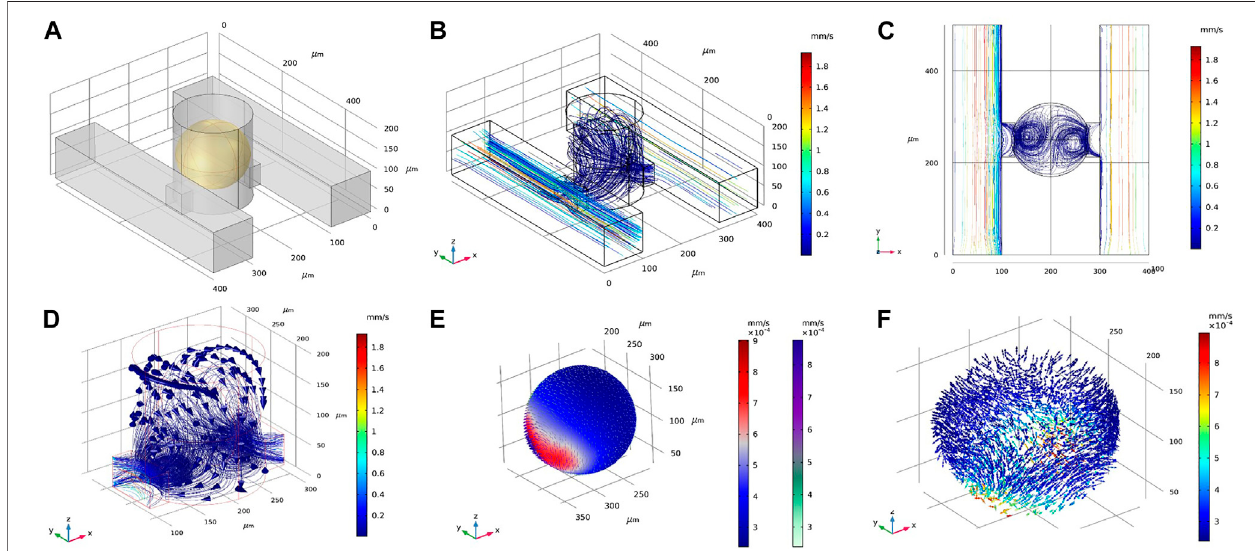
FIGURE3| Representativeresultsof fl owandtransportsimulationsinCOMSOL. (A) Asingleunitofthedouble-supplychannel(DSC)designofthespheroid-on-a- chipdevice,consistingofthemicrowellforspheroidformationandculture,twosupplychannels,twoconnectingchannels,andthespheroiditself(showninyellow). (B,C) Velocity streamlines in the DSC device. (D) Velocity vectors showing fl uid fl ow circulation overlaying streamlines of fl ow in the microwell. (E) Velocity magnitude of fl uid fl ow on the surface of the spheroid, shown as arrow surface and surface contours. (F) Velocity vectors within the spheroid (treated as porous medium).